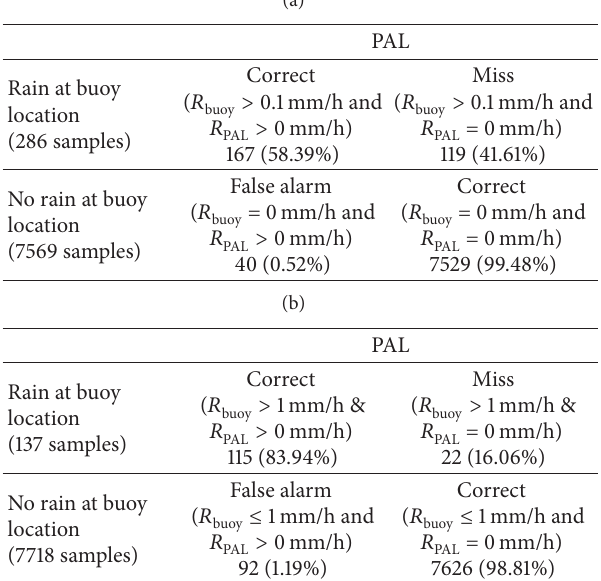
Table 2: Contingency table for the thresholds of (a) 0.1mm/h and and 𝑅 are the hourly cumulative rainfall mea- (b) 1mm/h. 𝑅 buoy PAL sured by the rain gauge installed on the “ODAS Italia 1” buoy and estimated by PAL,